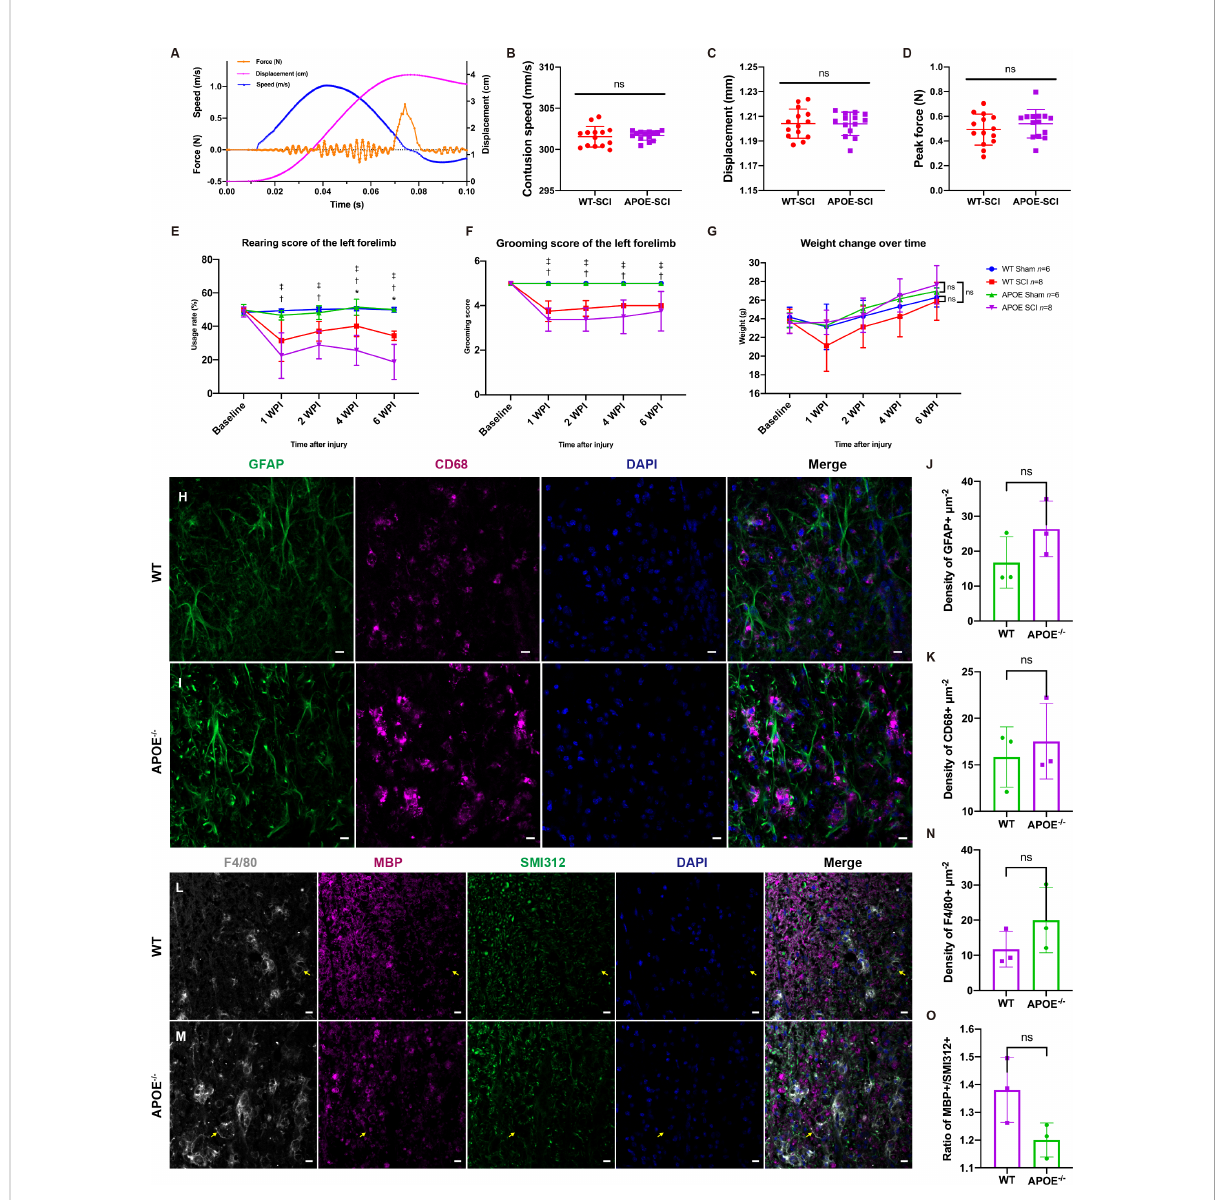
FIGURE 7 Apolipoprotein E (APOE) knockout aggravated dysfunction, increased neuroin fl ammation, and exacerbated white matter loss following spinal cord injury (SCI). (A) Typical changes in biomechanical parameters during contusion. Orange, contusion force; magenta, contusion displacement; blue, contusion speed. (B – D) There were no signi fi cant between-group differences in contusion displacement, speed or peak force. (E) Cylinder rearing test showed worse motor functional recovery in APOE -/- mice following SCI. (F, G) There were no signi fi cant differences in grooming scores and body weight between the two injured groups. (H – K) APOE -/- mice displayed aggravated neuroin fl ammation in the lesion rim. Green, GFAP+ astrocytes; purple, CD68+ macrophages/microglia; blue, DAPI+ cell nuclei. (L-O) APOE -/- mice showed increased white matter loss and microglia/macrophage in fi ltration following SCI. The myelin debris was engulfed by microglia/macrophages (yellow arrows). White, F4/80; purple, myelin basic protein (MBP); green, SMI312+ axons; blue, DAPI. ns P > 0.05, *P < 0.05 between the APOE-SCI and wild-type (WT)-SCI groups; † P < 0.05 between the APOE-SCI and APOE- Sham groups; ‡ P < 0.05 between the WT-SCI and WT-Sham groups. Scale bar (H, I, L, M) = 10